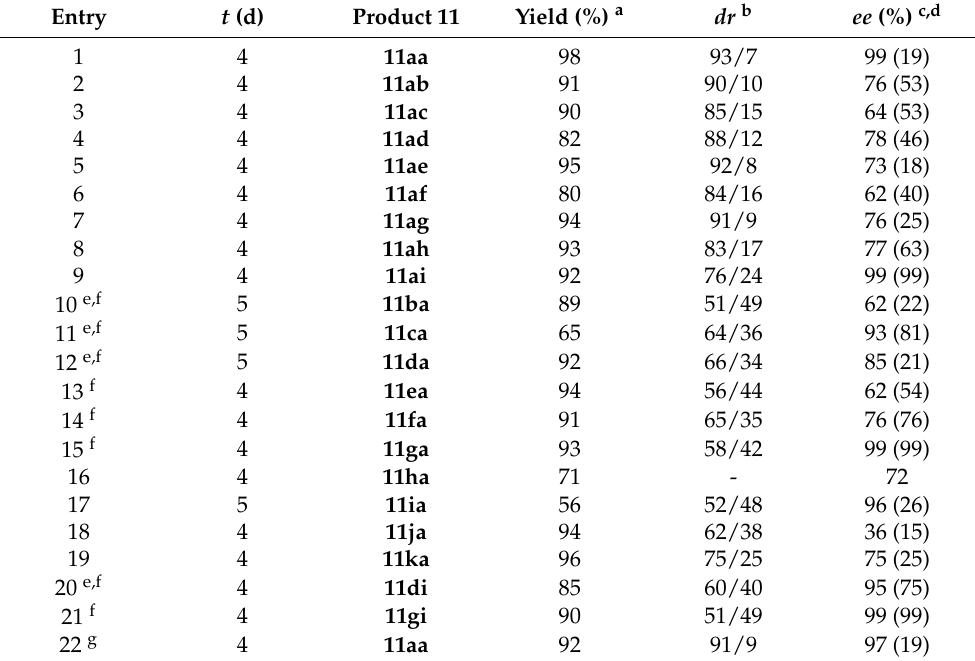
Table 2. Conjugate addition of ketones to maleimides organocatalyzed by 8